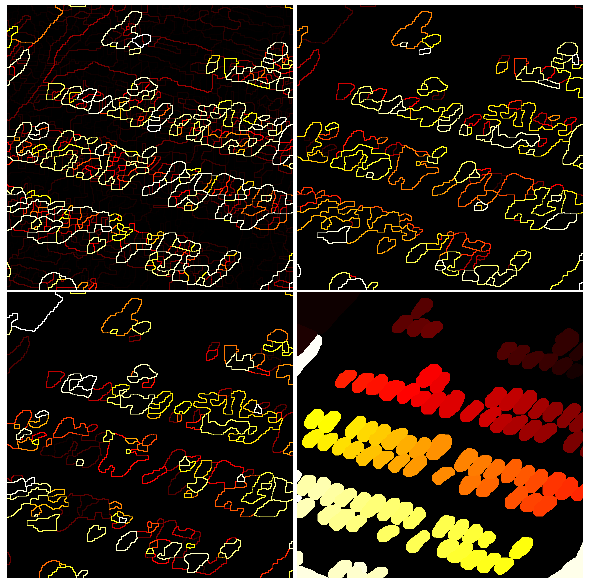
Figure 3. ucms, ranging from black (low probability) over red and yellow to white (high probability). From top to bottom, left to right: RGB-only ucm, DSM-weighted ucm, SAR-weighted ucm, ground truth